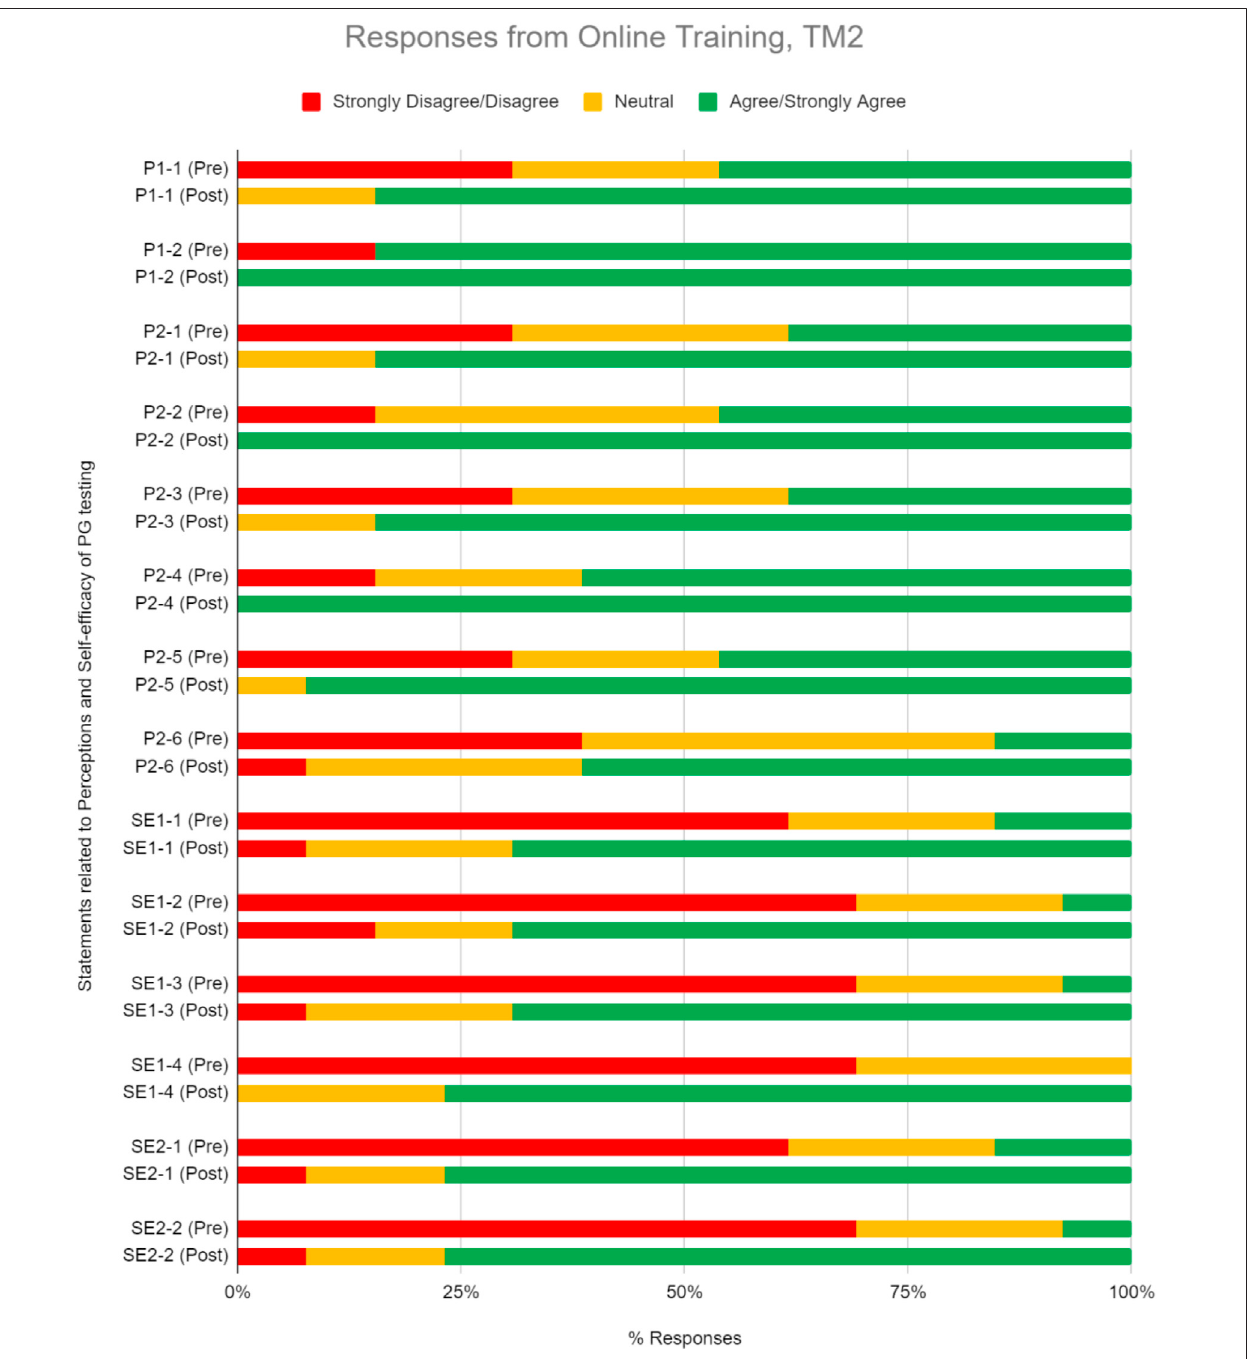
FIGURE 5 | Percent of respondents relative to 5-point Likert-type scale labels pre- and post-PGx training conducted online for TM2 in perception (P) and self ef fi cacy (SE) sections. Three questions in P section (P1-2, P2-2, and P2-4) received 100% of respondents answering agree/strongly agree in the post-training questionnaire. TM2 pre-training survey knowledge evaluation, n (cid:1) 34; TM2 post-training survey knowledge evaluation, n (cid:1) 21.